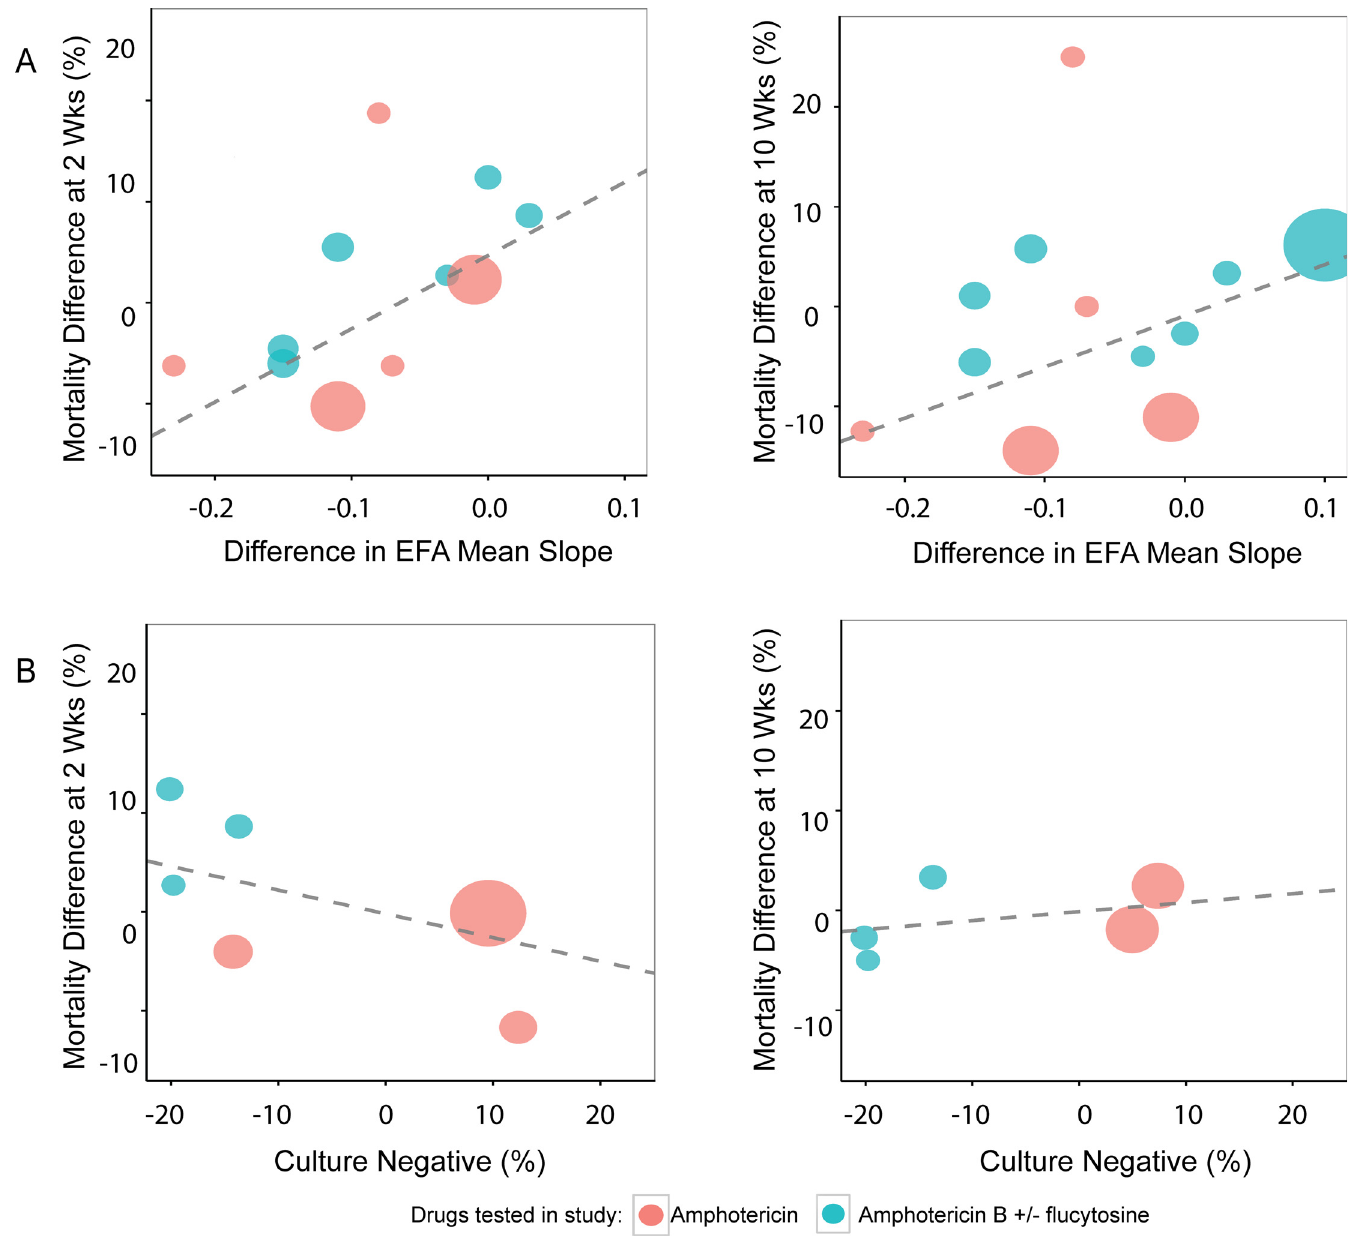
Fig 4. Trial – level correlations of treatment effect on EFA compared to treatment effects on ACM: All studies with non-missing data are displayed. N = 9 studies and 26 arms A) Average EFA slope vs ACM at 2 and 10 weeks (6 studies and 18 arms). B) % CSF culture negative vs ACM at 2 and 10 weeks (4 studies and 12